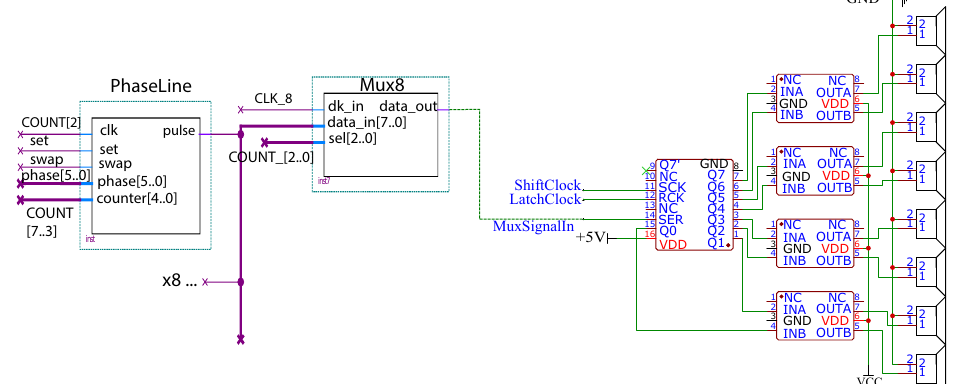
Figure 2. At the left, the FPGA blocks in charge of generating the signals are presented, 8 phaseLine blocks (signal generators) are multiplexed into one digital line to reduce the required number of output pins. At the right, the circuit schematic represents a shift register that demultiplexes the signal into 8 channels that get amplified by four dual Metal–oxide–semiconductor field-effect transistor (MOSFET) drivers and fed into the ultrasonic